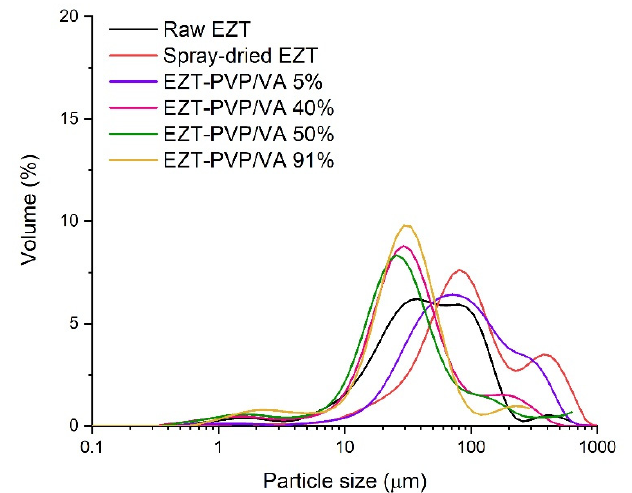
Figure 2. Particle size distribution of raw ezetimibe, drug spray-dried without a carrier and selected EZT-PVP/VA solid dispersions. Table 1. Particle size of solid dispersions obtained using the laser diffraction method.